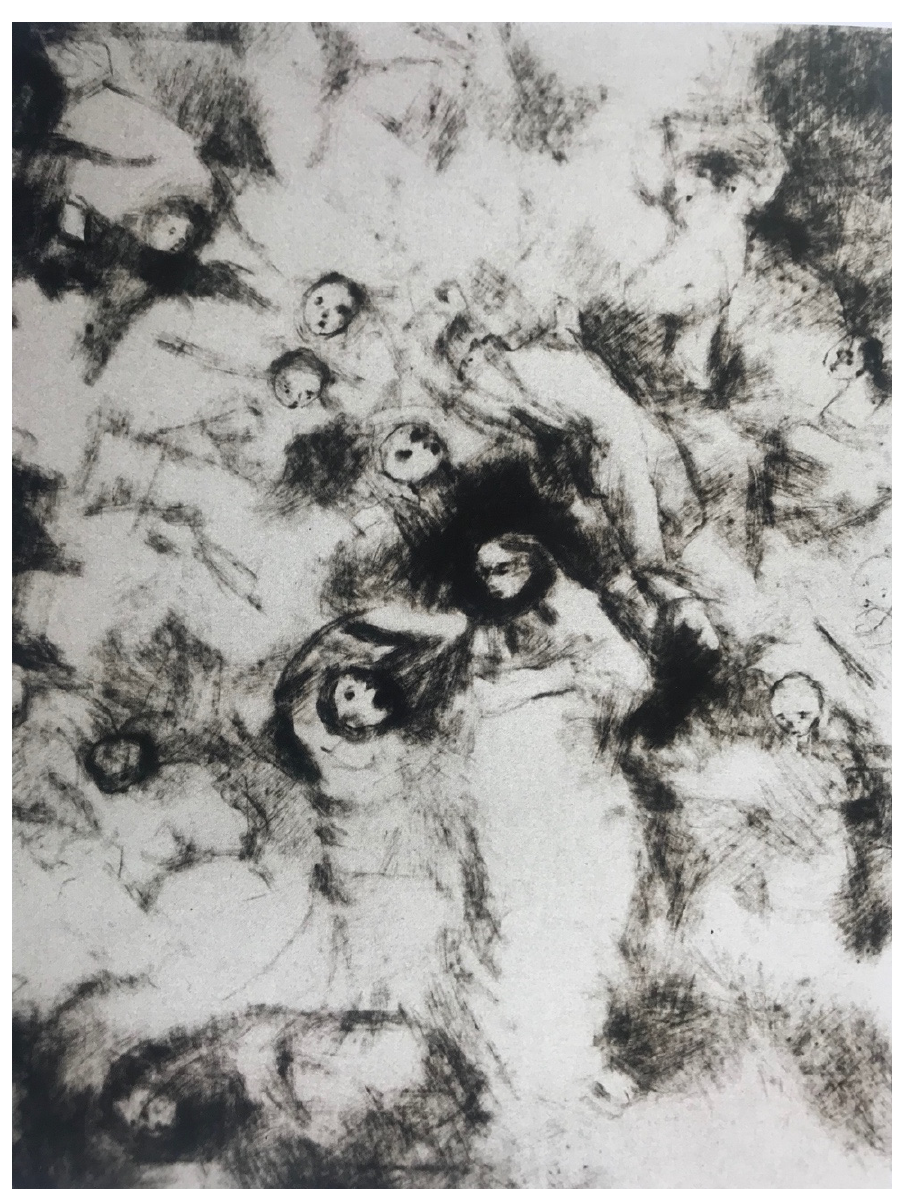
Figure 10. Vasily Chekrygin, The Raising of the Dead , 1922, pencil and charcoal on paper, collection of K.I. Grigorishin, Moscow.